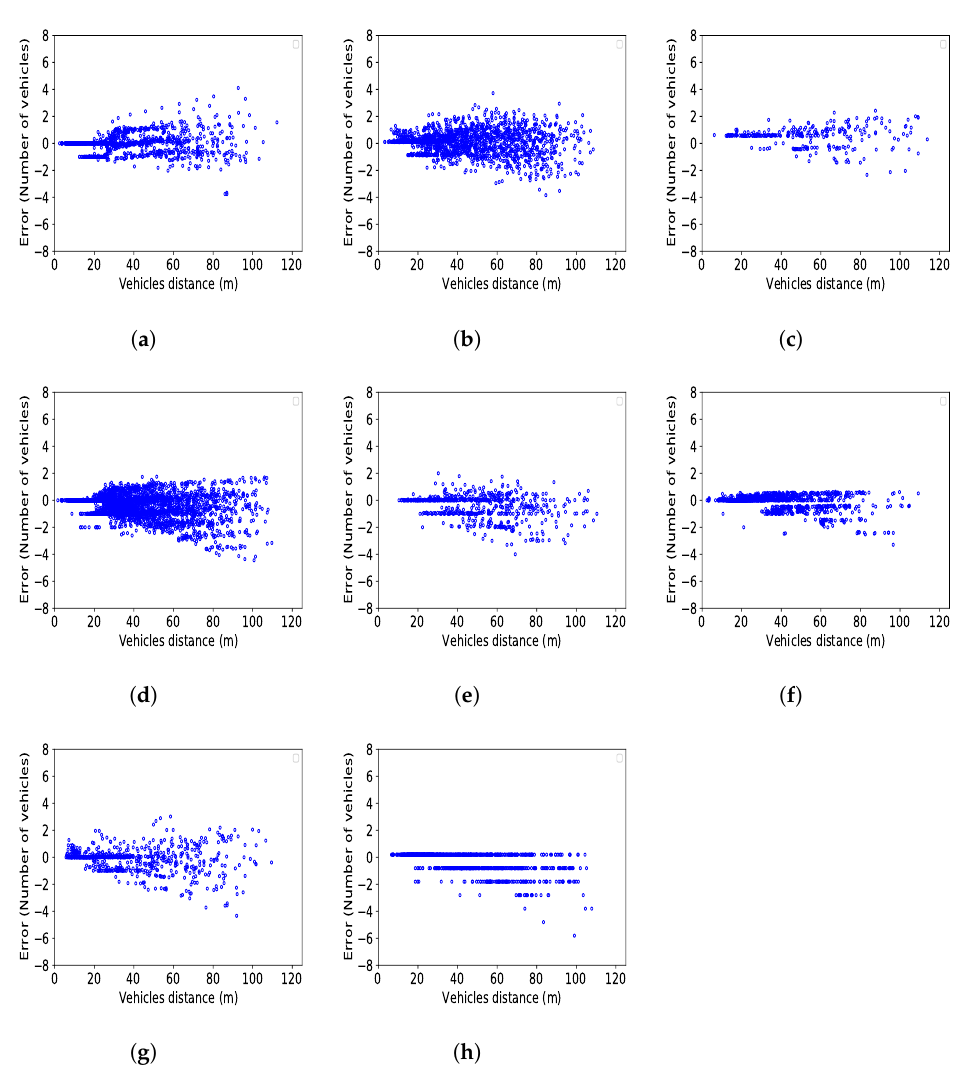
Figure 10. Error of estimations based on distance of CV pairs. ( a ) Q-Q model; ( b ) Q-S model; ( c ) Q-F model; ( d ) S-S model; ( e ) S-F model; ( f ) F-F model; ( g ) S-Q model; ( h ) F-SQ